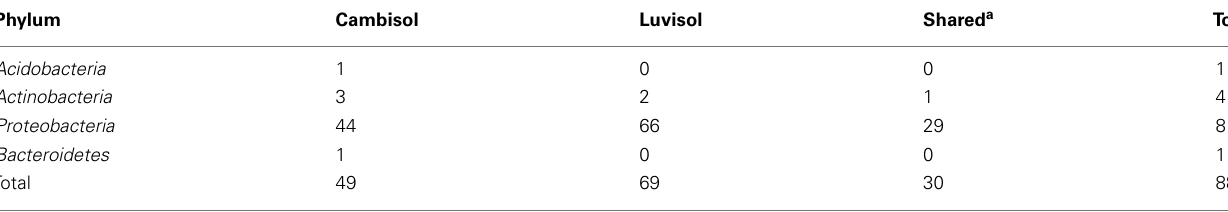
TableA4 | Number of OTUs ( > 97% similarity) significantly (unadjusted p < 0.05) enriched in phenanthrene-spiked soils. Phylum Cambisol